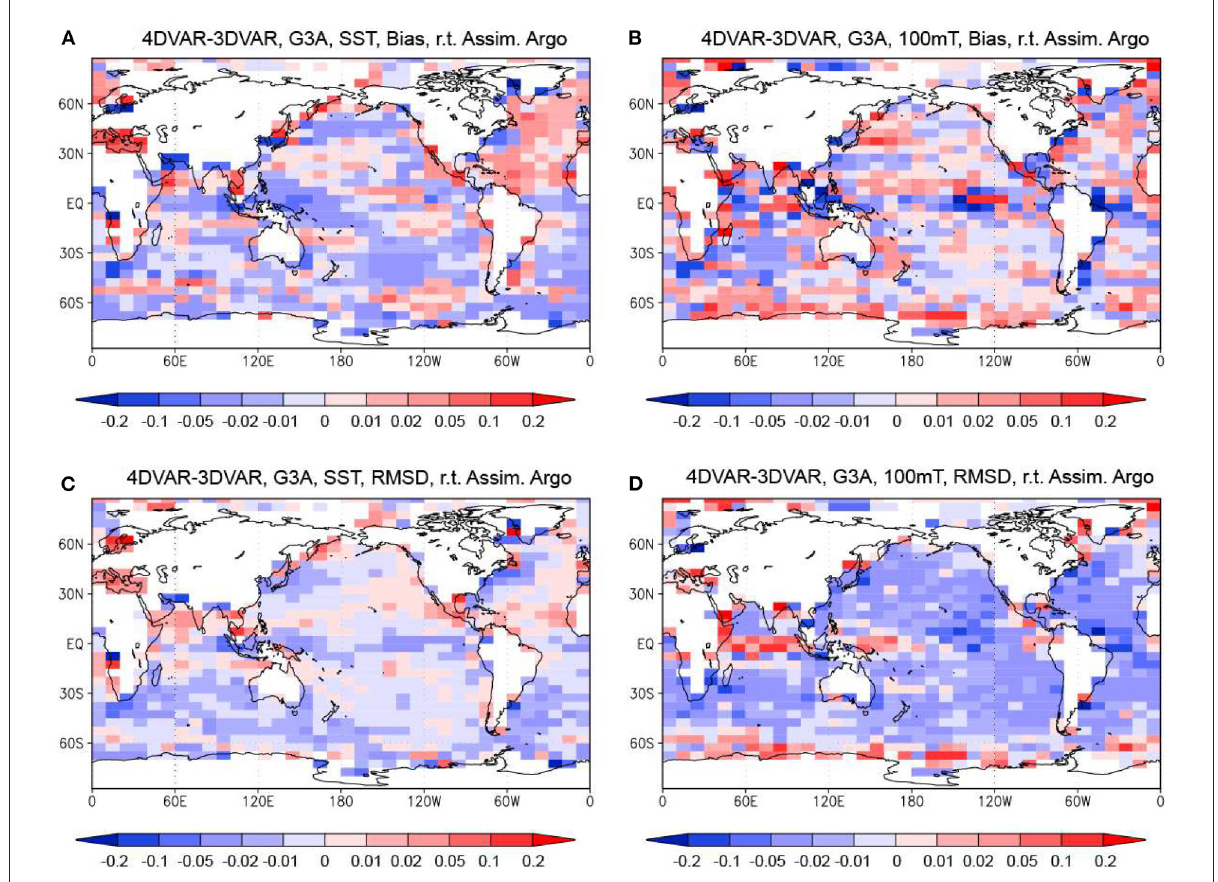
FIGURE5 Difference of bias absolute values and RMSDs of the MOVE-G3A temperature relative to the assimilated Argo float data between the 4DVAR and 3DVAR Runs. (A, B) Difference of bias absolute values at the surface and 100m depth. (C, D) Difference of RMSDs at the surface and 100m depth. Blue colors mean that the bias absolute value or the RMSD is smaller for the 4DVAR Run. Units in ◦